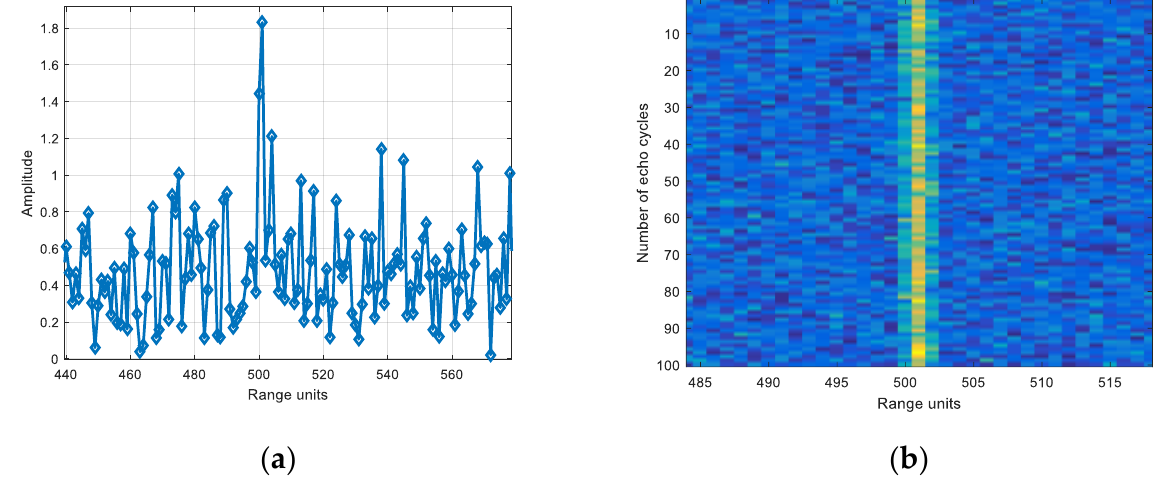
Figure 32. Electromagnetic simulation experiment II model diagram.